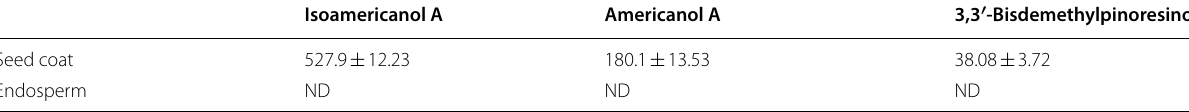
The data are the mean